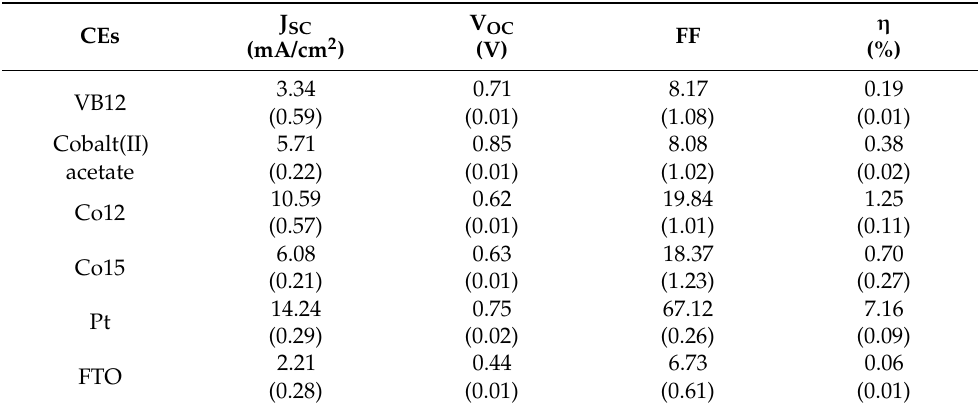
Figure 3. J–V characteristics of DSSCs with various cobalt derivatives as CEs. Table 1. Performance levels of DSSCs with various cobalt derivatives as CEs. The values in the brackets are the standard deviation.